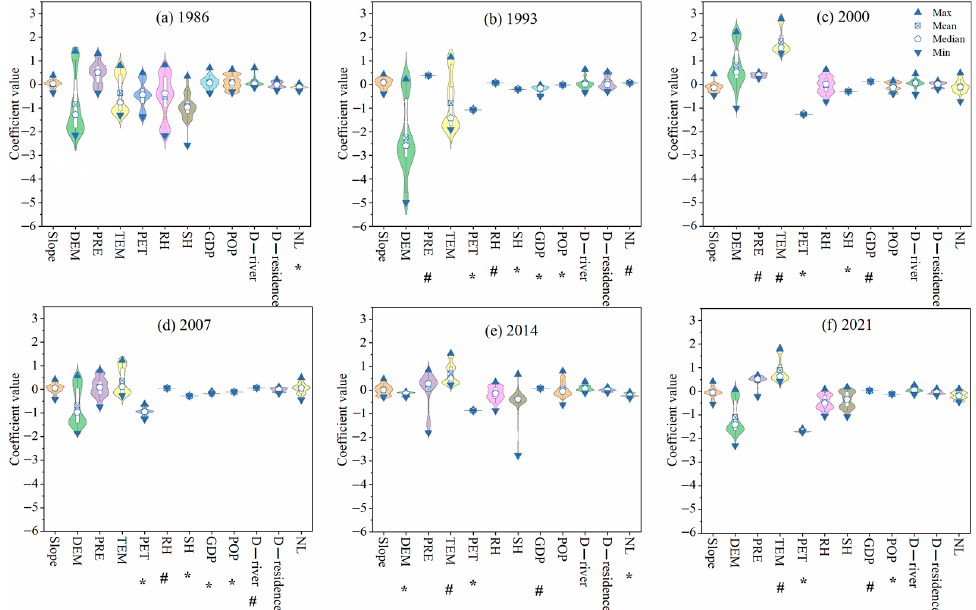
Figure 5. Coefficients of related factors by MGWR from 1986 to 2021. (a–f): 1986; 1993; 2000; 2007;